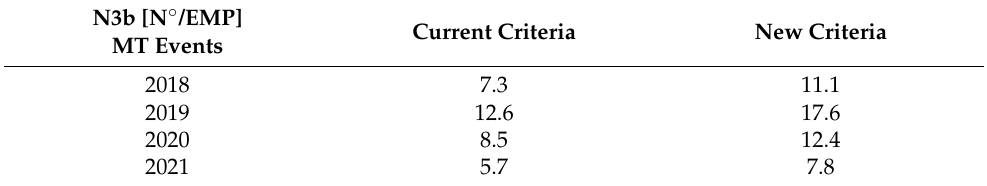
Table 14. N3b comparison: HV events. N3b [N ◦ /EMP] AT Events